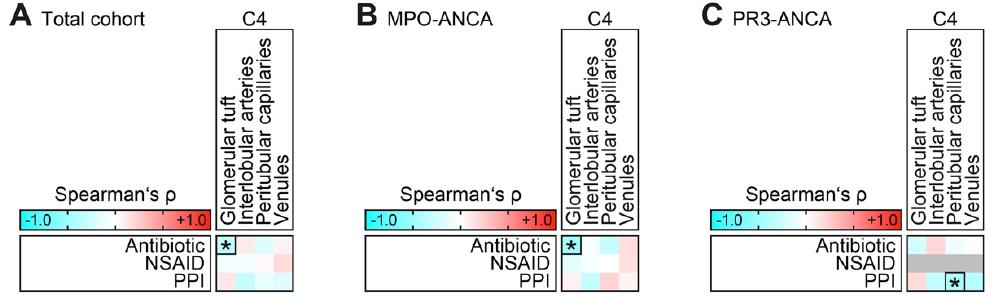
Figure 3. Association between intrarenal C4 deposits and co-medication in ANCA-associated renal vasculitis. ( A – C ) Association between antibiotic treatment of infectious complications and C4 deposits localized to the glomerular tuft, interlobular arteries, peritubular capillaries, and venules are shown by heatmap reflecting mean values of Spearman’s ρ . Asterisks (*) indicate significant associations in the univariate analysis ( p < 0.05), rectangle boxes indicate significant associations in the stepwise regression analysis ( p < 0.05). The grey line for NSAID within the heatmap reflects no data analysis because the respective parameter was absent in all cases.